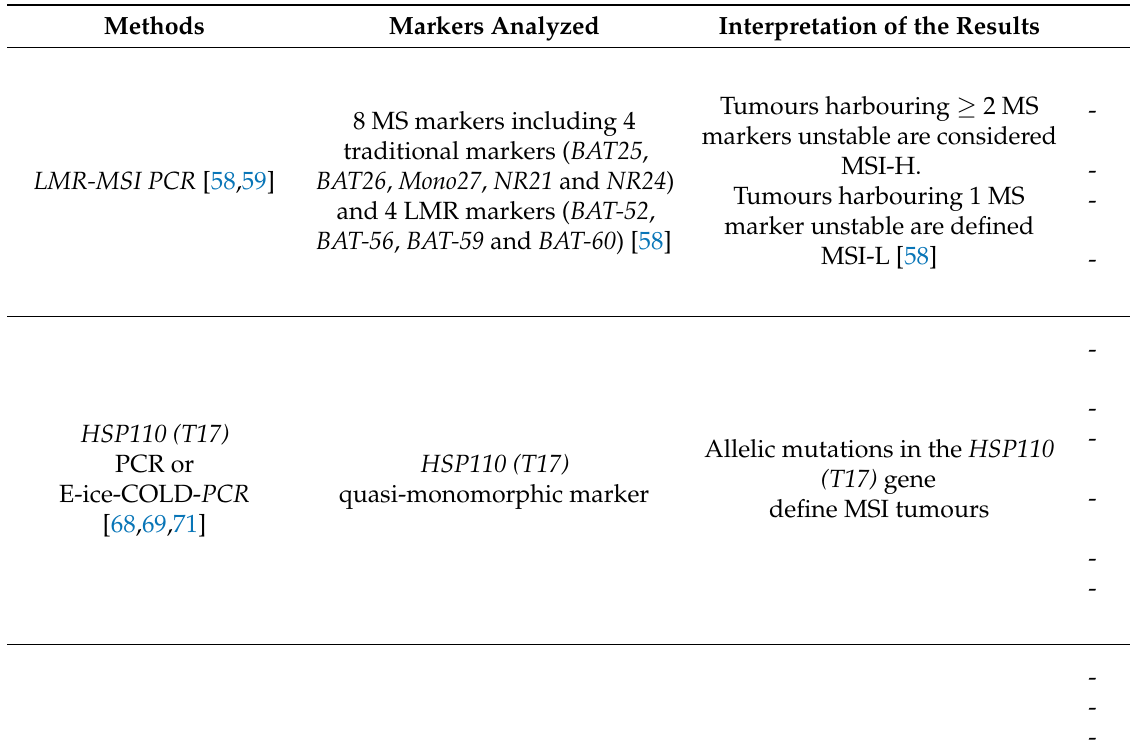
Table 2. Examples of emerging tissue-based methods for MSI